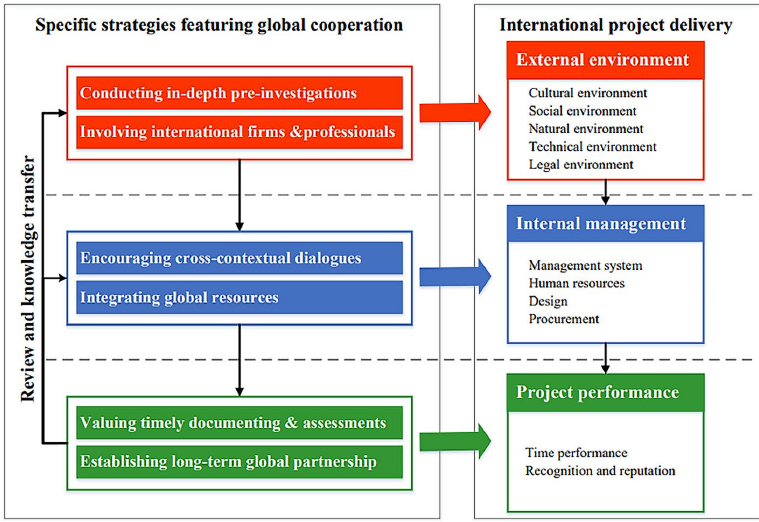
Figure 6. Strategies on improving time performance of international construction